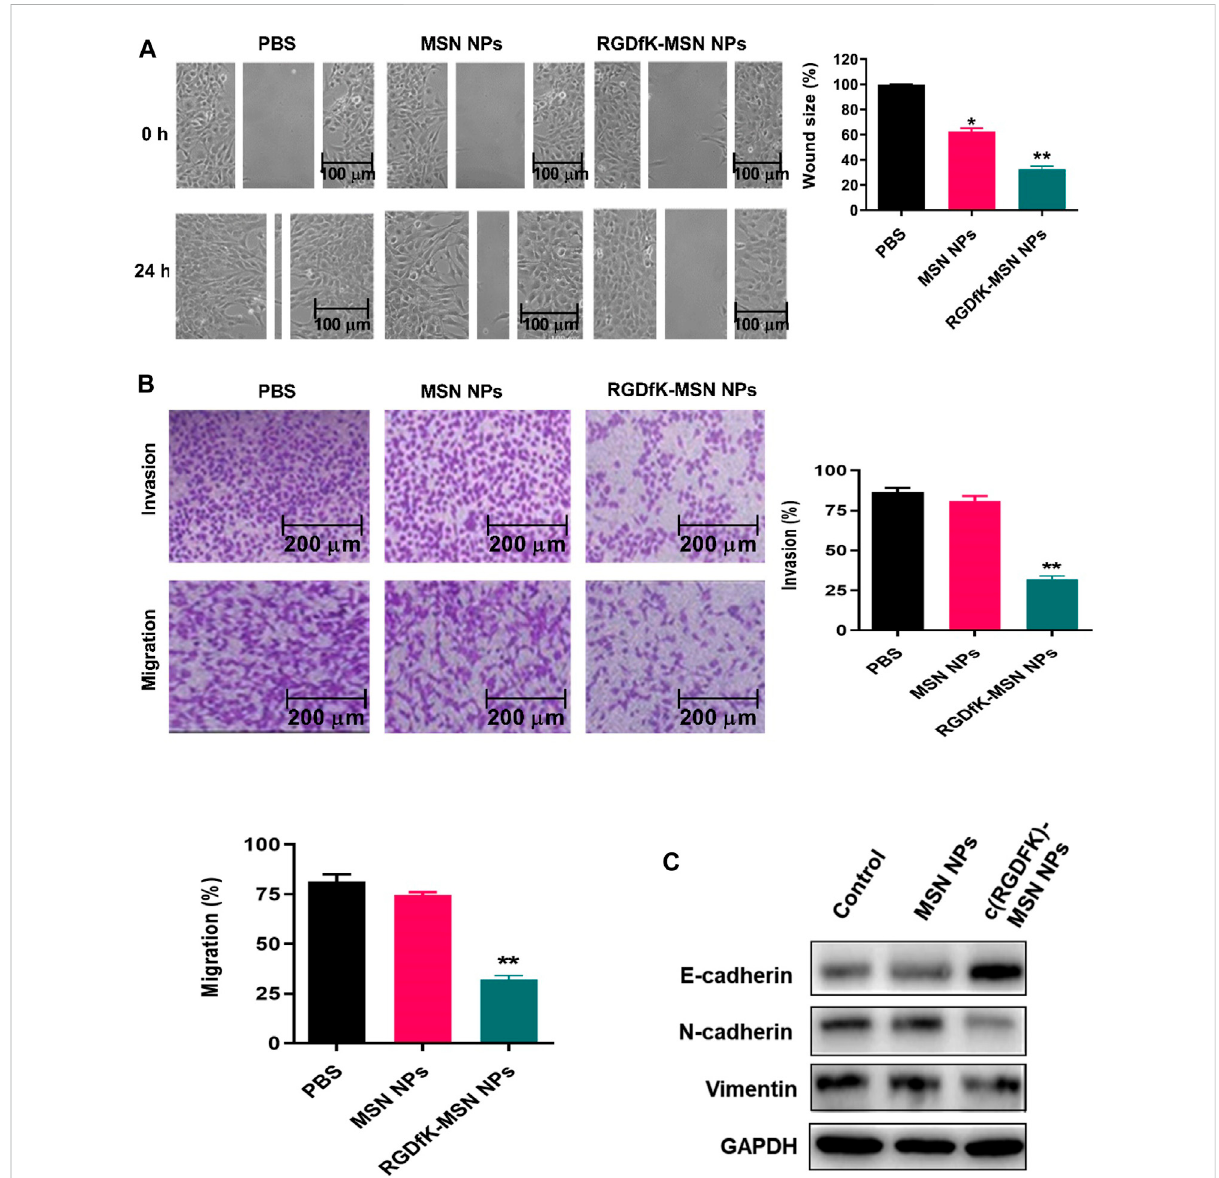
c(RGDfK)-MSN NPs suppressed the migration and invasion of T24 cells. (A) The wound width of T24 cells was photographed after incubation withc(RGDfK)-MSNNPsandMSNNPsfor24 h(Scalebaris100 µm). (B) InvasionandmigrationofT24cellsafterincubationwithc(RGDfK)-MSNNPs andMSNNPsfor24 h(Scalebaris200 µm). (C) EMT-associatedproteinlevelsinT24cellsafterincubationwithc(RGDfK)-MSNNPsandMSNNPsfor 24 h. Data are reported as mean ± SD (** p < 0.01). Abbreviation: MSNs, mesoporous silica